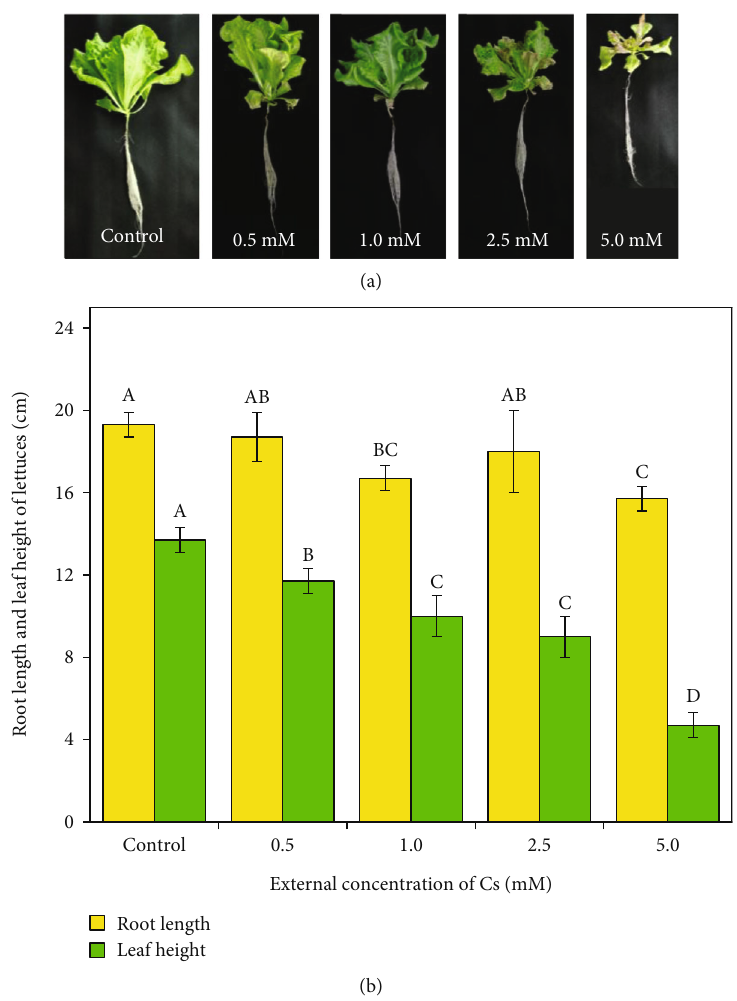
Figure 1: E ff ects of Cs + exposure on lettuce root lengths and leaf height. Notes: the di ff erent lowercase letters indicate that signi fi cant di ff erences ( P < 0 : 05 ) exist between treatment groups with di ff erent Cs levels in lettuce (LSD